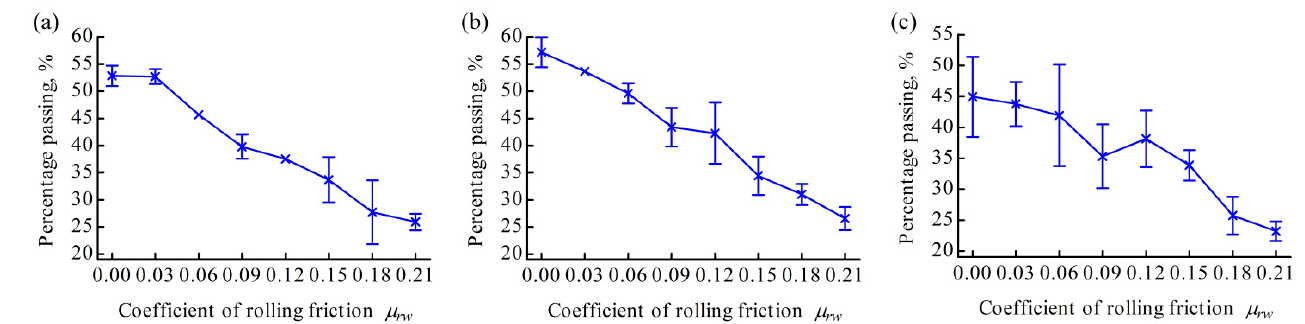
Figure 8. Influence of coefficient of rolling friction between seed particles and boundary on percentage passing for three varieties: ( a ) Liangyu99, ( b ) Xianyu 335 and ( c ) Zhengda 999.